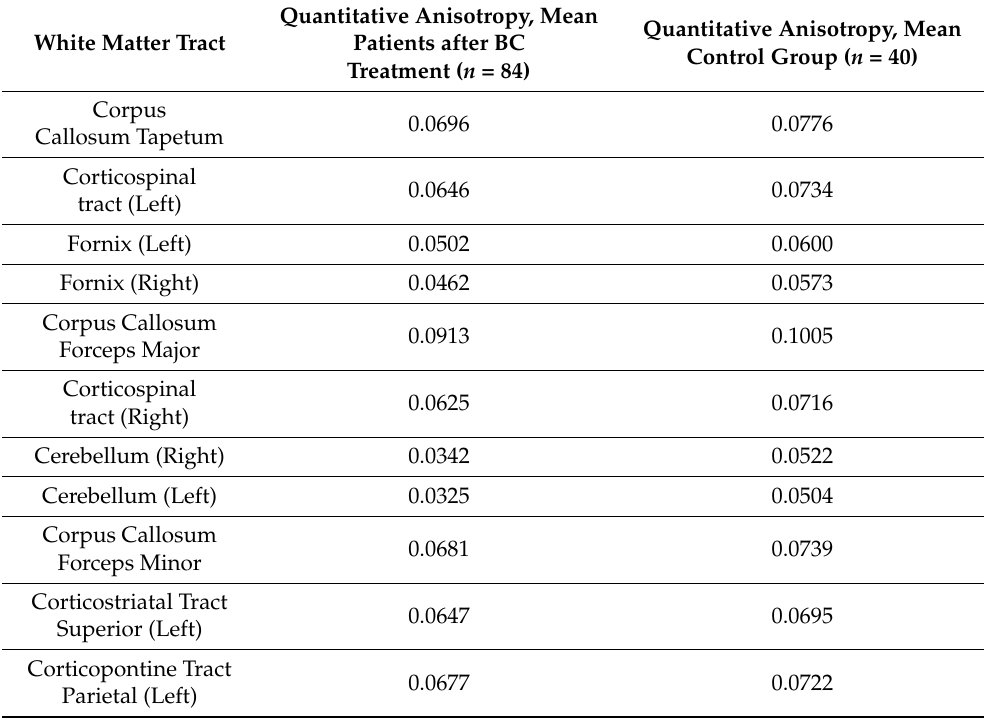
Figure 1. Three-dimensional reconstruction of the white matter tracts with the signs of a decrease in quantitative anisotropy in patients after BC treatment in comparison with the control group (( a ) axial plane, ( b ) coronal plane). Table 4. White matter tracts with lower quantitative anisotropy in patients after BC treatment in comparison with the control group.